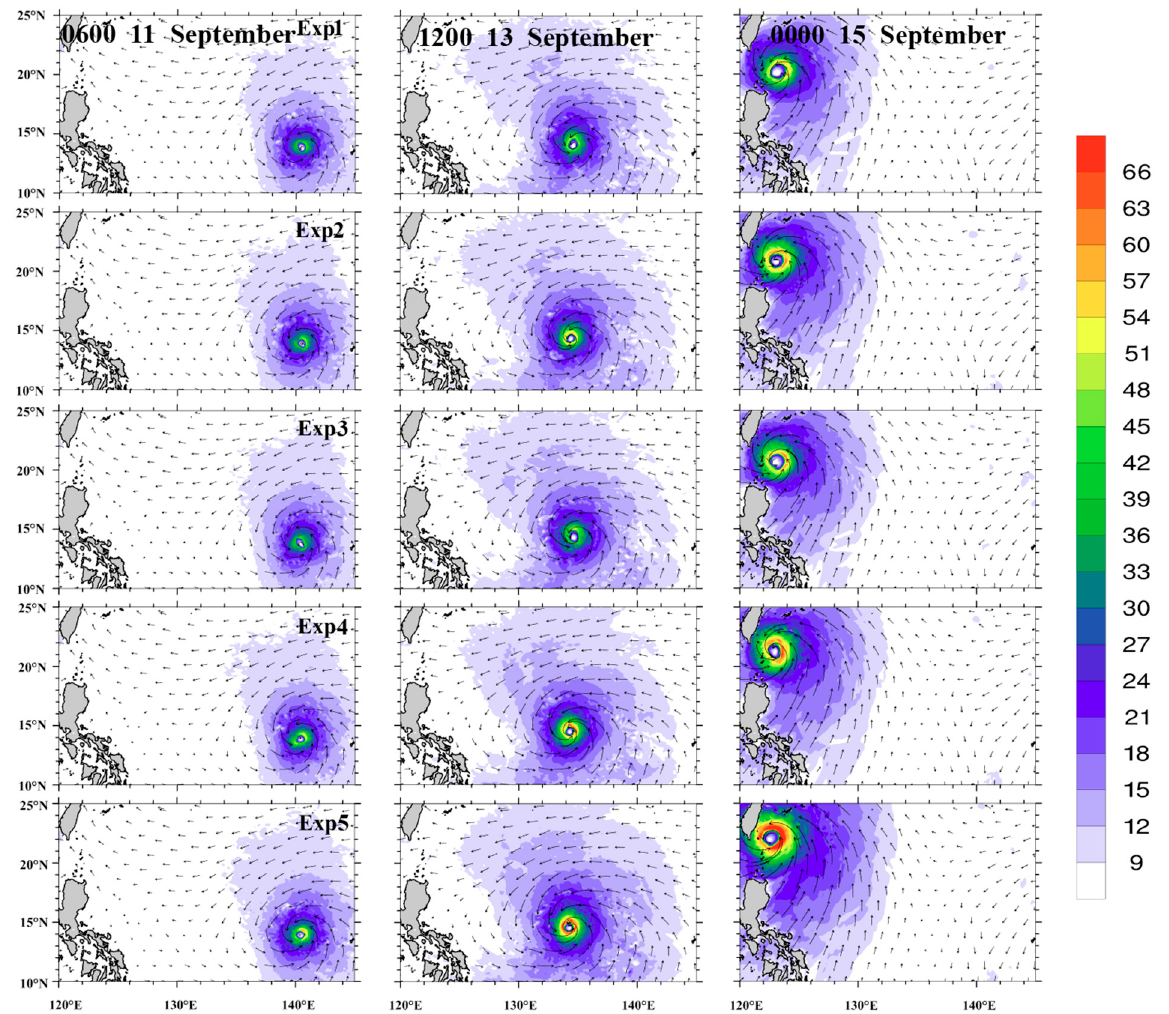
Figure 11. The spatial distribution of the 10 m wind speed (m/s) as simulated by the five experiments. The colors represent the wind speed values, and the arrows represent the wind direction.